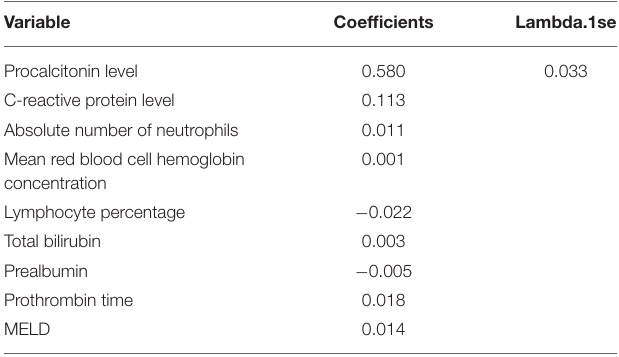
TABLE 2 | Least absolute shrinkage and selection operator (LASSP) regression coefficient table.